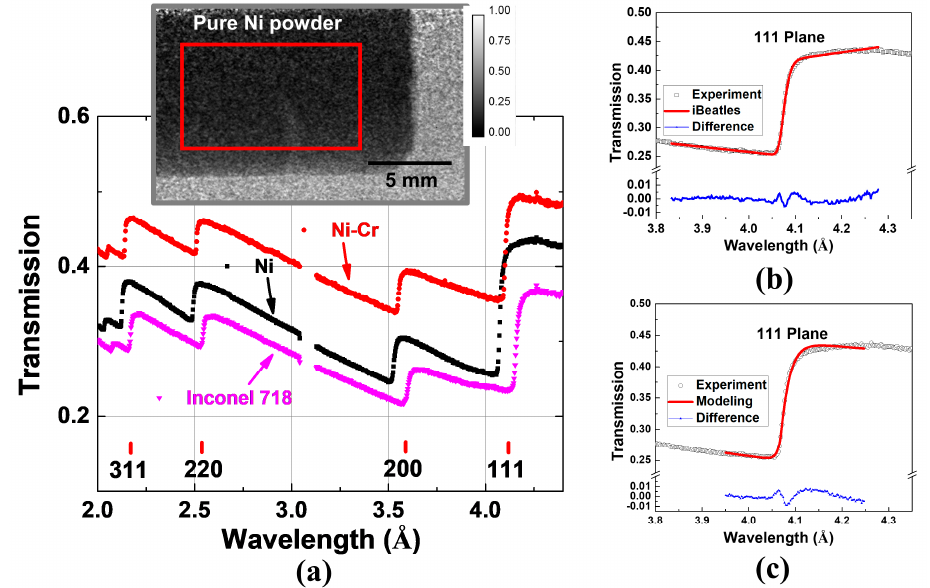
Figure 2. ( a ) Measured relative transmission spectra (i.e., uncorrected for sample thickness) of pure Ni, Ni 39 Cr 11 , and Inconel 718 powder samples. Neutron transmission radiograph in ( a ) displaying the dark sample contrast was obtained at a wavelength near the (200) Bragg edge. Comparison between experimental and fitting results of the (111) plane using ( b ) iBeatles and ( c ) Bragg-edge modeling, respectively.